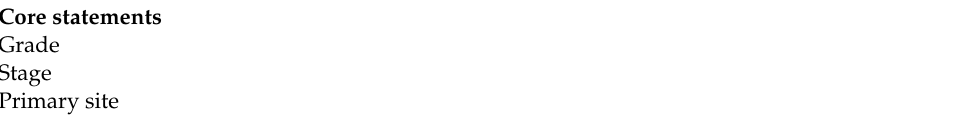
Figure 2. Round 1 ranking of appropriateness statements, ordered by importance. Each radial spoke represents a Round 1 appropriateness statement. Weighted averages for ratings of “Importance” (red line) and “Measurability” (blue line) are presented. Many statements rated as important were not measurable, and a few measurable indicators were not rated as important. Statements taken forward to Round 2 are shown by grey dots, and tended to be both important and measurable (>3 shaded in green). The wording of each statement (e.g., Q72) is shown in Supplementary Material S7. The small expert group ( n = 17) met in Round 2 to discuss appropriateness statements indicated by grey dots in Figure 2. This included statements rated both important and measurable in Round 1. Table 1. QPI statements assessed in Round 2 and the rationale for further